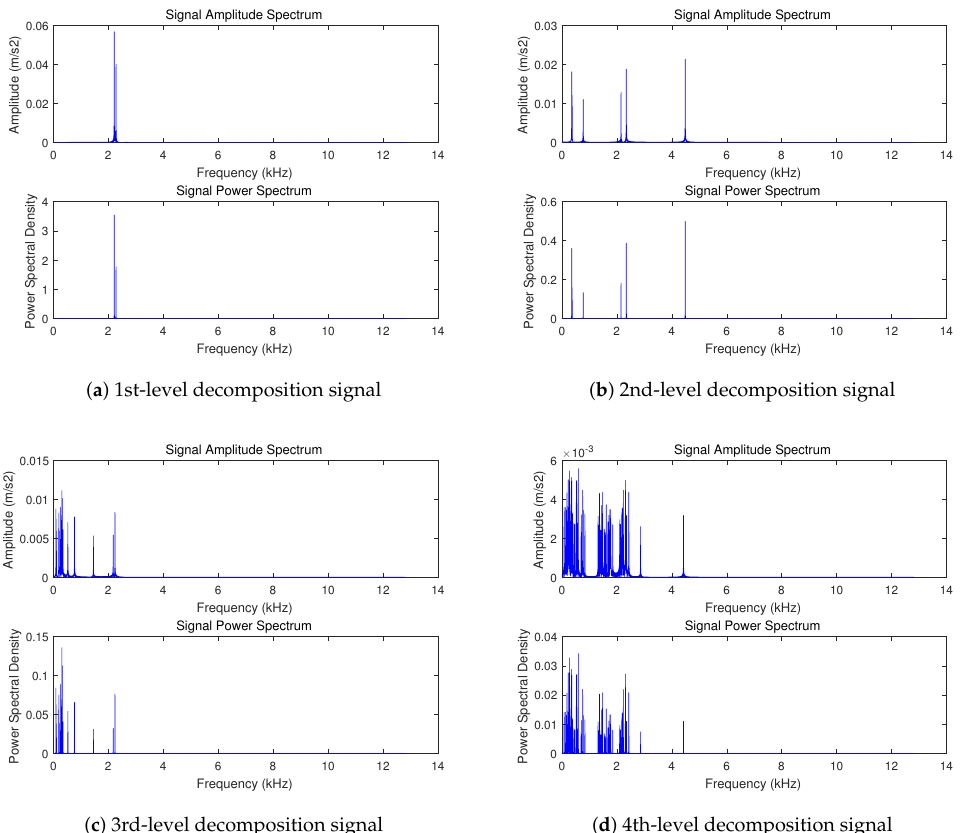
Figure 6. Amplitude spectrum and power spectrum of